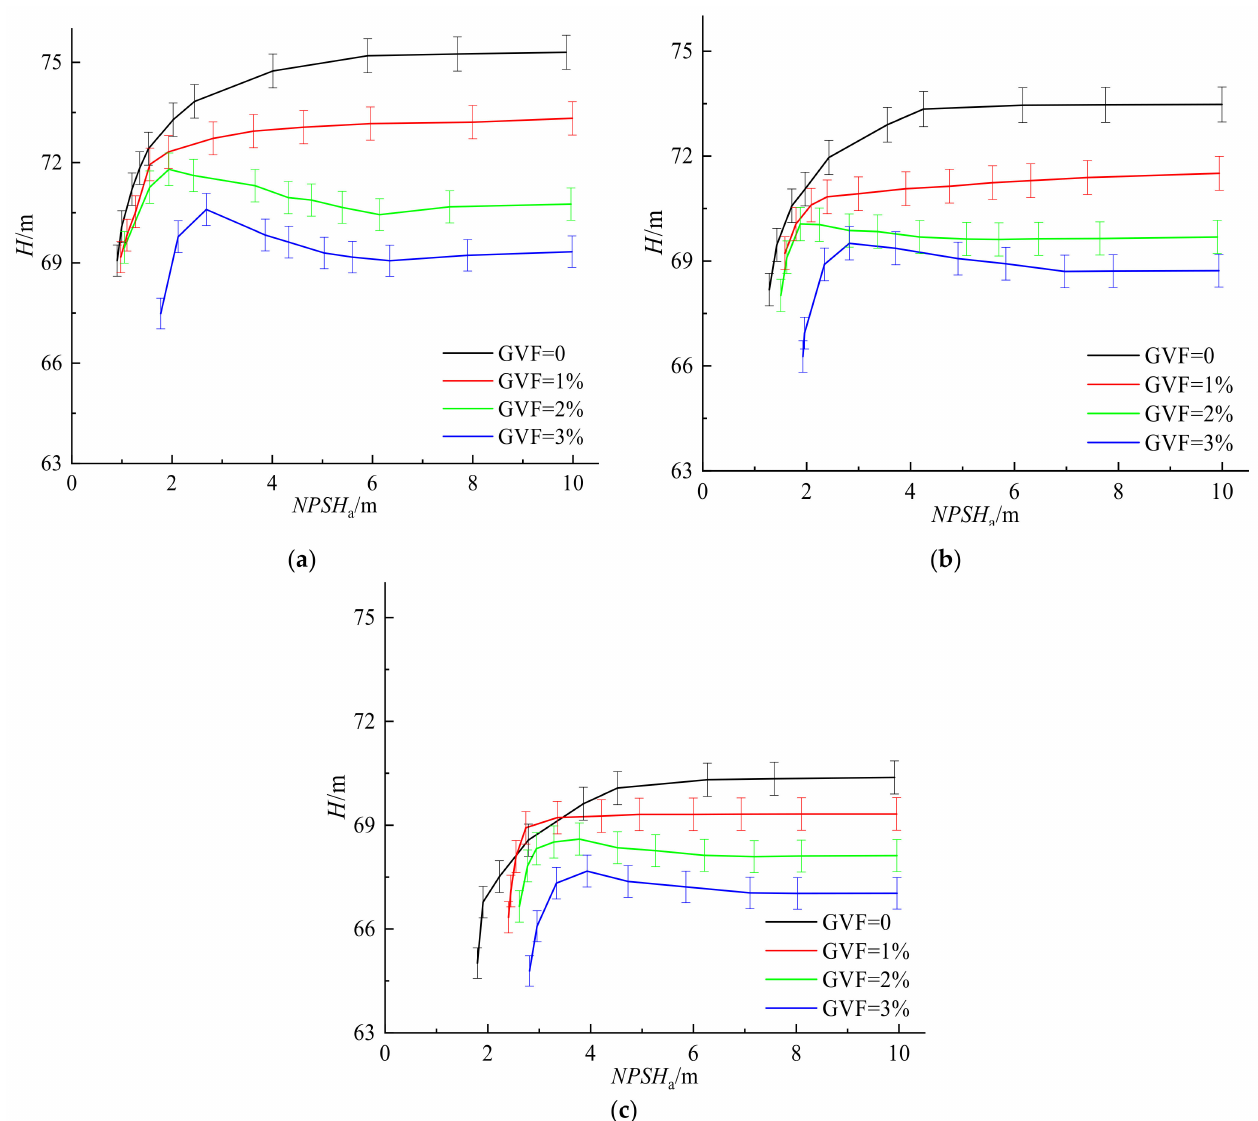
Figure 5. Cavitation performance of the model pump under different IGVF conditions and different flow rates: ( a ) 0.75 Q ld ( b ) 1.0 Q ld and ( c ) 1.25 Q ld